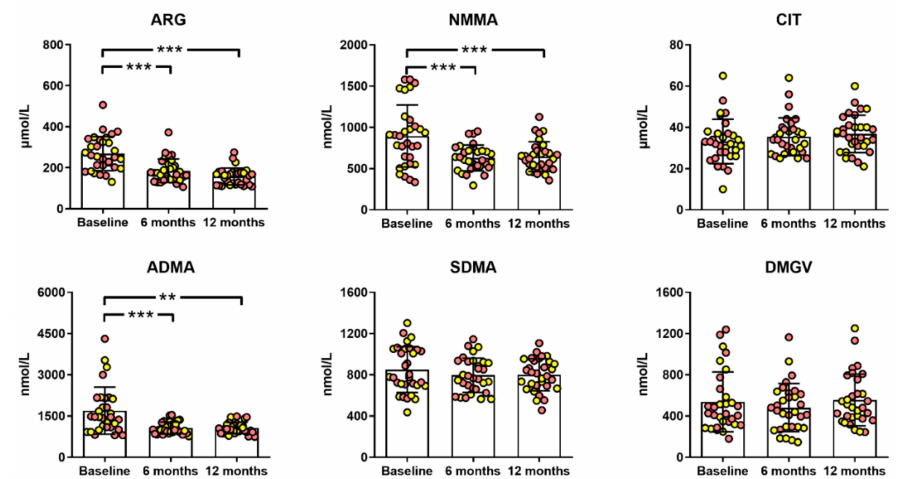
Figure 2. Benefits of bariatric surgery on serum methylarginines. **: p < 0.01; ***: p < 0.001 (Friedman test, Benjamini–Hochberg correction for multiple testing). ARG, arginine; NMMA, N-monomethylarginine; CIT, citrulline; ADMA, asymmetric dimethylarginine; SDMA, symmet- ric dimethylarginine; DMGV, dimethylguanidino valerate. Yellow and red dots indicate patients subjected to a sleeve gastrectomy or a gastric bypass, respectively. Table 3. Comparison of the clinical characteristics and biomarker concentrations between the healthy controls and the obese patients after bariatric surgery (12 months post-surgery). Obese Patients Parameter Healthy Controls p -Value (12 Months Post-Surgery)